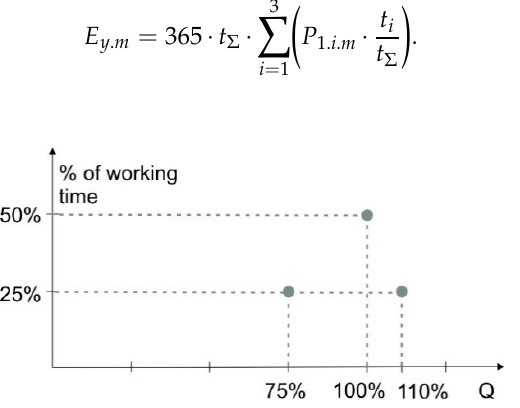
Figure 1. Pump interpolated curves and initial points: ( a ) Q - H curve of the pump and dependence of the pump power on water flow; ( b ) dependence of the pump efficiency on water flow.